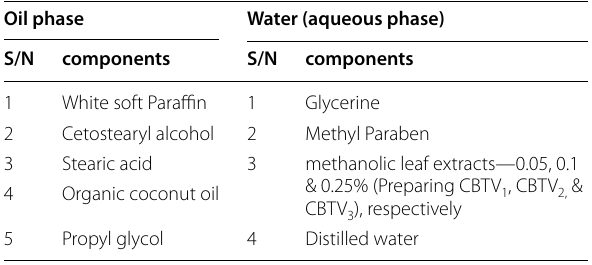
Table 1 Composition of the herbal cream